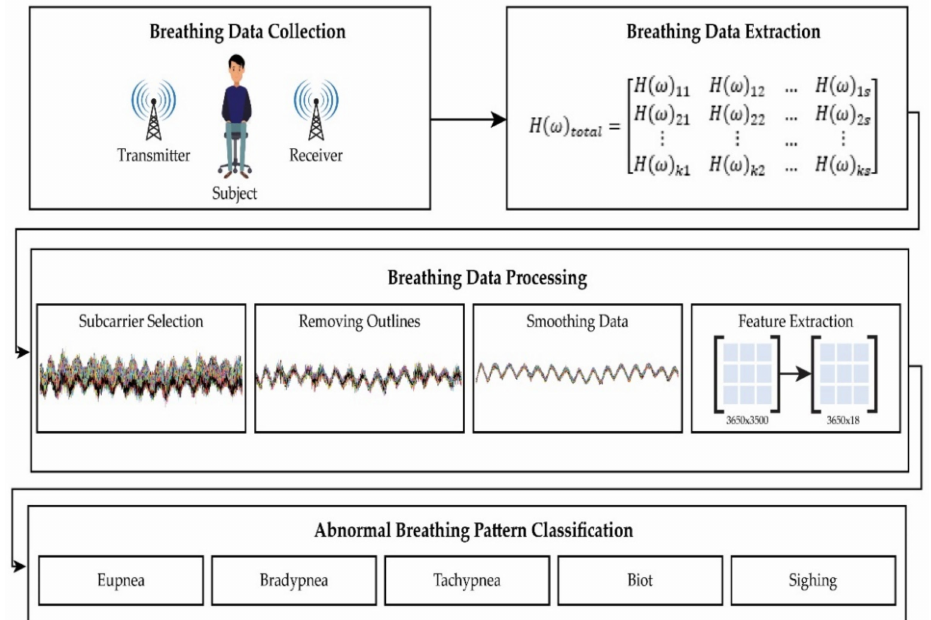
Figure 3. Methodology block